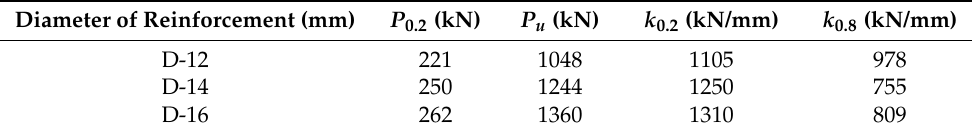
Table 11. Analysis of shear stiffness at different diameters.